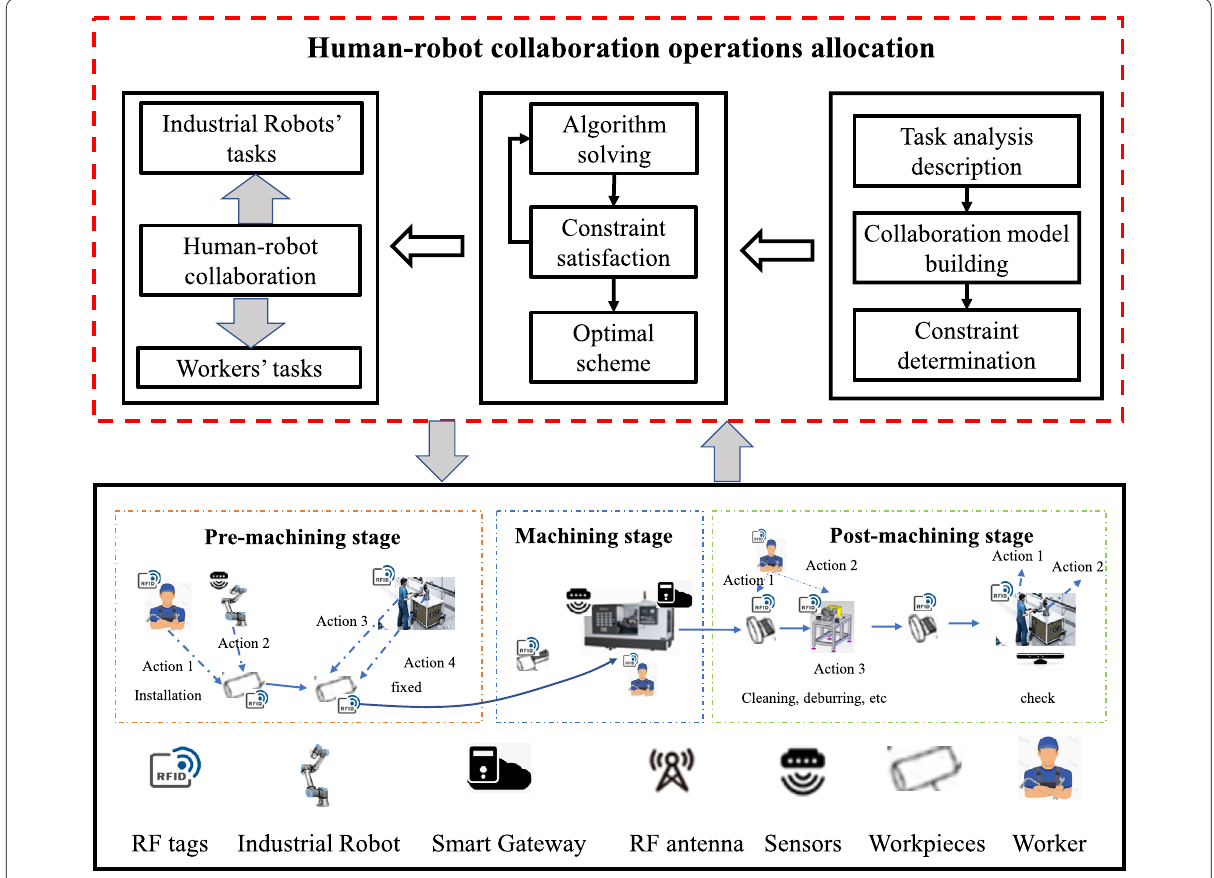
Figure 1 Human–robot collaboration